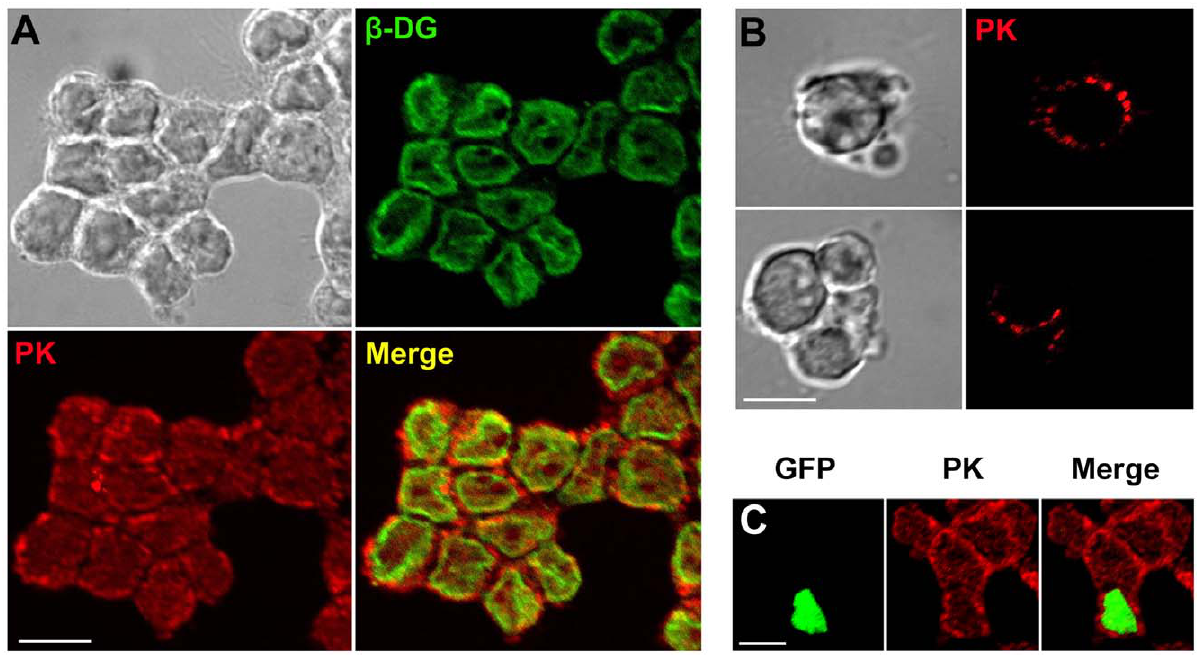
Figure 2. Localization of endogenous pikachurin to the cell surface in Y79 cells. (A) Immunofluorescent images of pikachurin (PK, red) and b -DG (green). Most pikachurin label is present on the extracellular side of the immunolabeling for DG, predominantly a membrane bound protein. (B) Live imaging of pikachurin in cells shows punctuate extracellular staining. (C) Overexpression of dystroglycan in transfected Y79 cells, indicated by the nuclear GFP, had no significant influence on pikachurin staining. A representative field of view is shown here, and another example can be found in Fig. S1. Bar=10 m m.